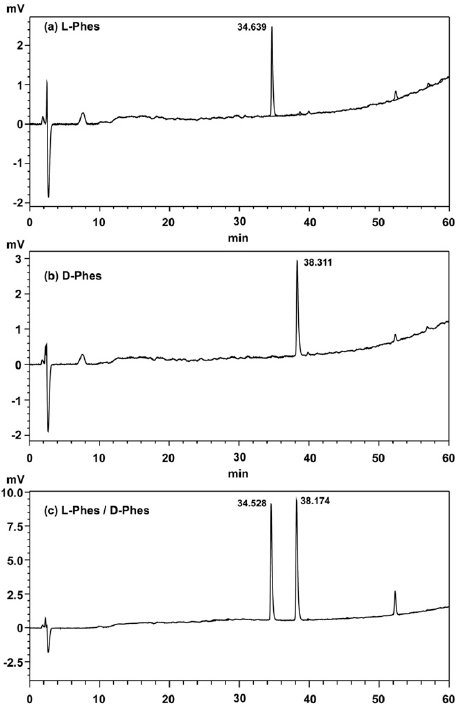
Figure 1. HPLC charts with C18 ODS column of ( a ) L-Phes, ( b ) D-Phes, ( c ) L-Phes, and D-Phes.